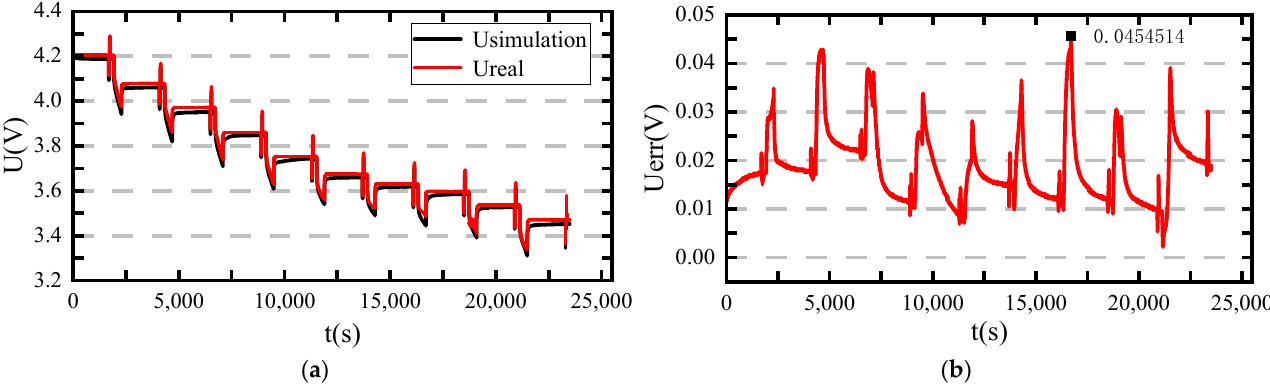
Figure 7. Model validation results comparison and error. ( a ) Comparison of model validation results. ( b ) Error of model validation results.